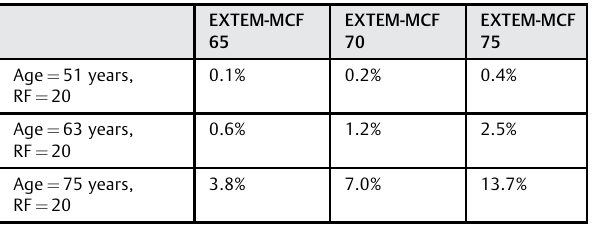
Table 4 Mortality 30 days in %, related to age (y) and